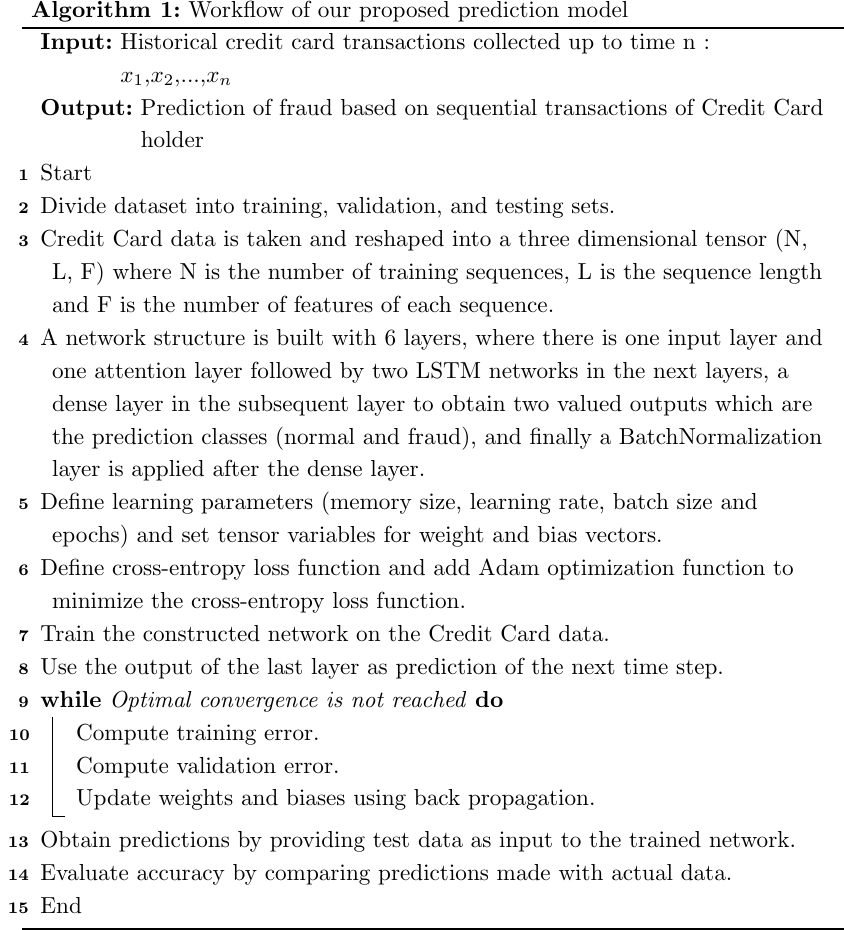
Algorithm 1: Workflow of our proposed prediction